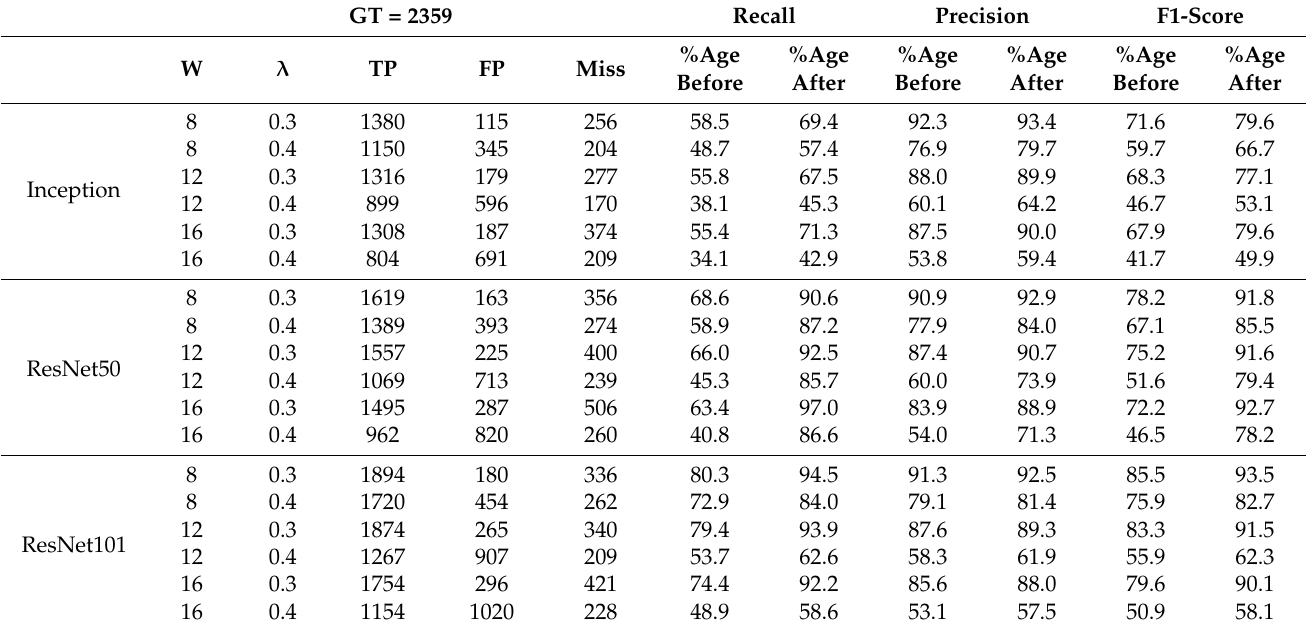
Table 3. Detections of all temporal segments with refinements. Detections are refined using W = 8, 12, and 16 with λ = 0.3 and 0.4. The refined detection shows total number of TP, FP, and missed detections and F1-score.